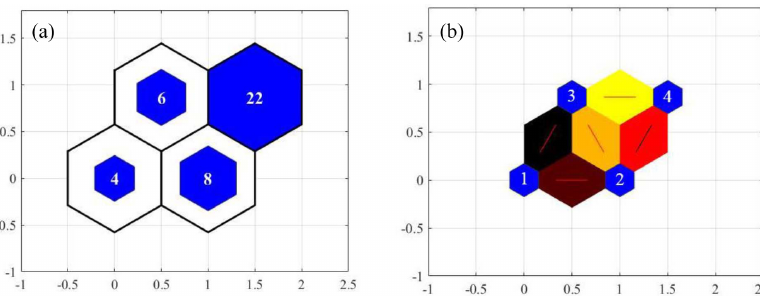
Figure 5. SOM topology and determining the number of samples for each cluster (a) , SOM neighbor weight distances and neighbor connec- tions (b) .